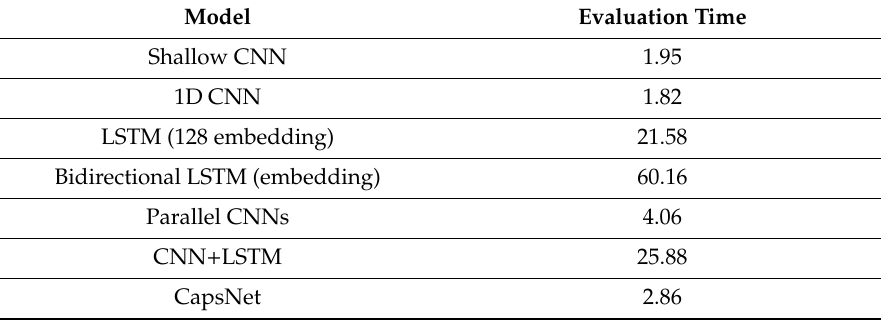
Table 8. Evaluation time (in ms) of a single